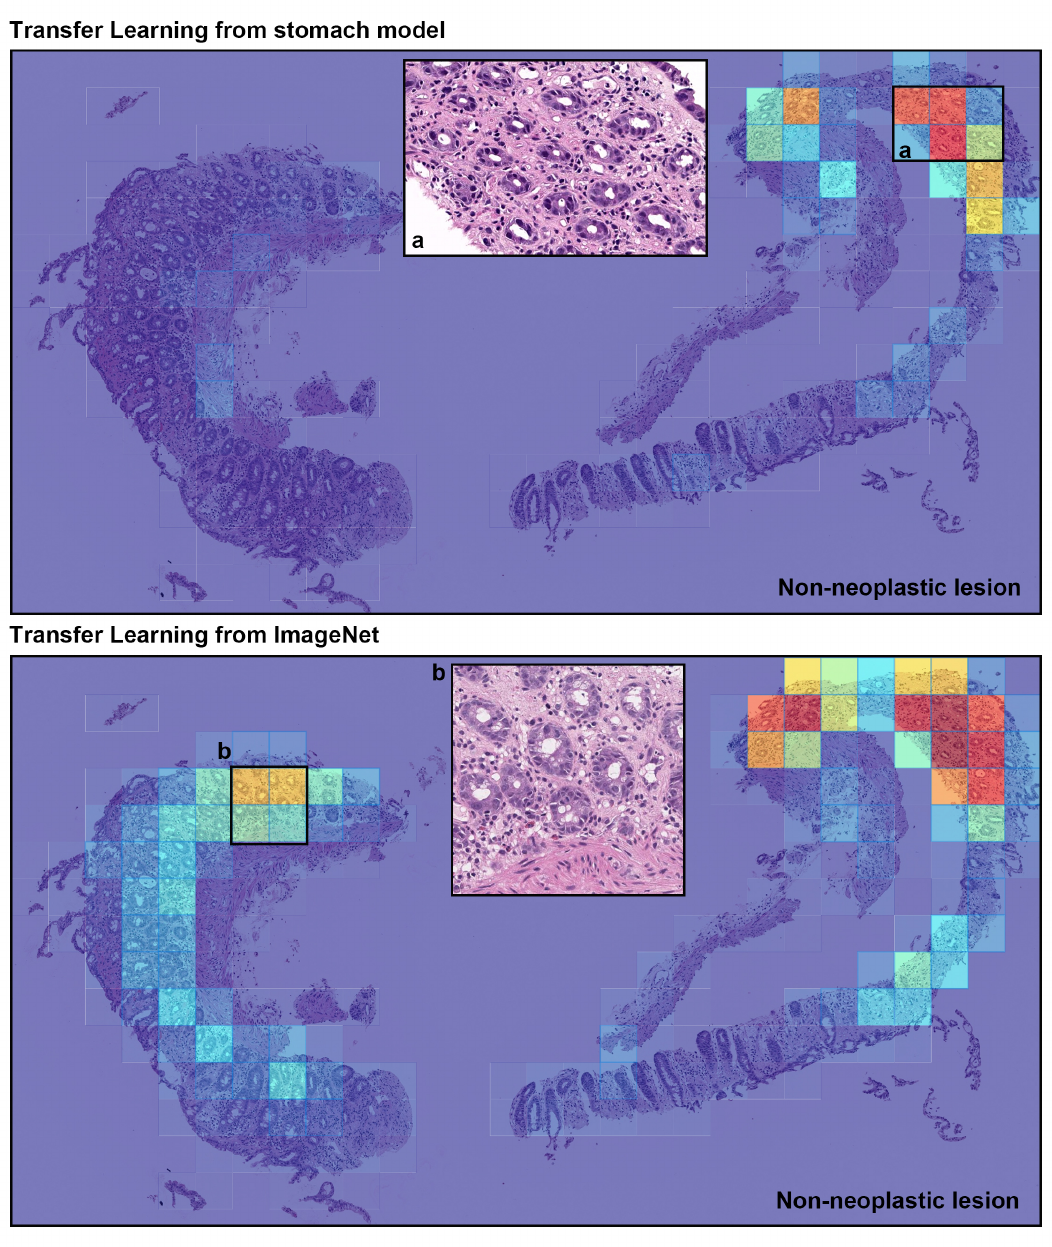
Figure 4. A representative example of poorly differentiated colorectal adenocarcinoma (ADC) false positive prediction output on a case the from endoscopic biopsy test set. Histopathologically, this case is a non-neoplastic lesion (colitis). Heatmap images exhibited false positive prediction of poorly differentiated ADC using transfer learning from stomach model ( upper panel ) and transfer learning from ImageNet model ( lower panel ). The inflammatory tissue with plasma cell infiltration (a and b) is the primary cause of false positive due to its analogous nuclear and cellular morphology to poorly differentiated ADC